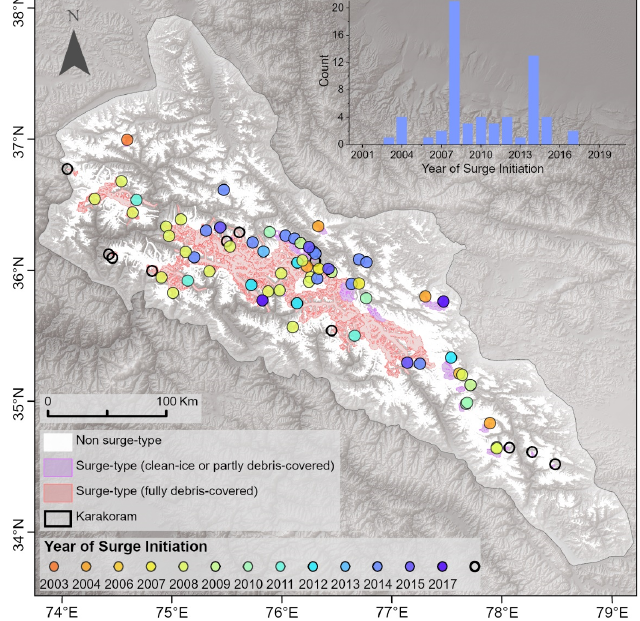
Figure 4. The spatial distribution of glacier-surging activities and the identified surge-type glaciers in the Karakoram during the period 2000–2020. Shaded circles represent locations and starting years of surging detected by the abrupt changes in the NDSI time series. Black hollow circles represent the locations where significantly persistent increases in the NDSI trend were detected, which indicate the significantly persistent advances of surge-type glaciers during the period. The upper-right inset shows the statistics of the starting time of the surging activities.